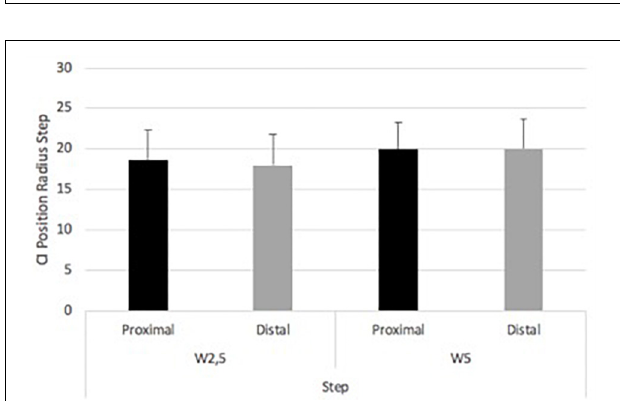
FIGURE 9 | Experiment 2. Complexity Index position radius within foci and between wall distances in the step